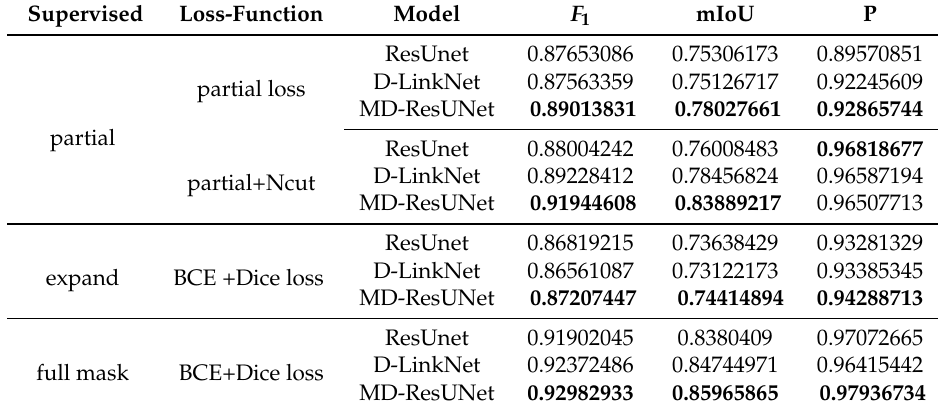
Table 5. Road extraction performance using different supervised data and different loss function and different deep learning method on dataset 1 .